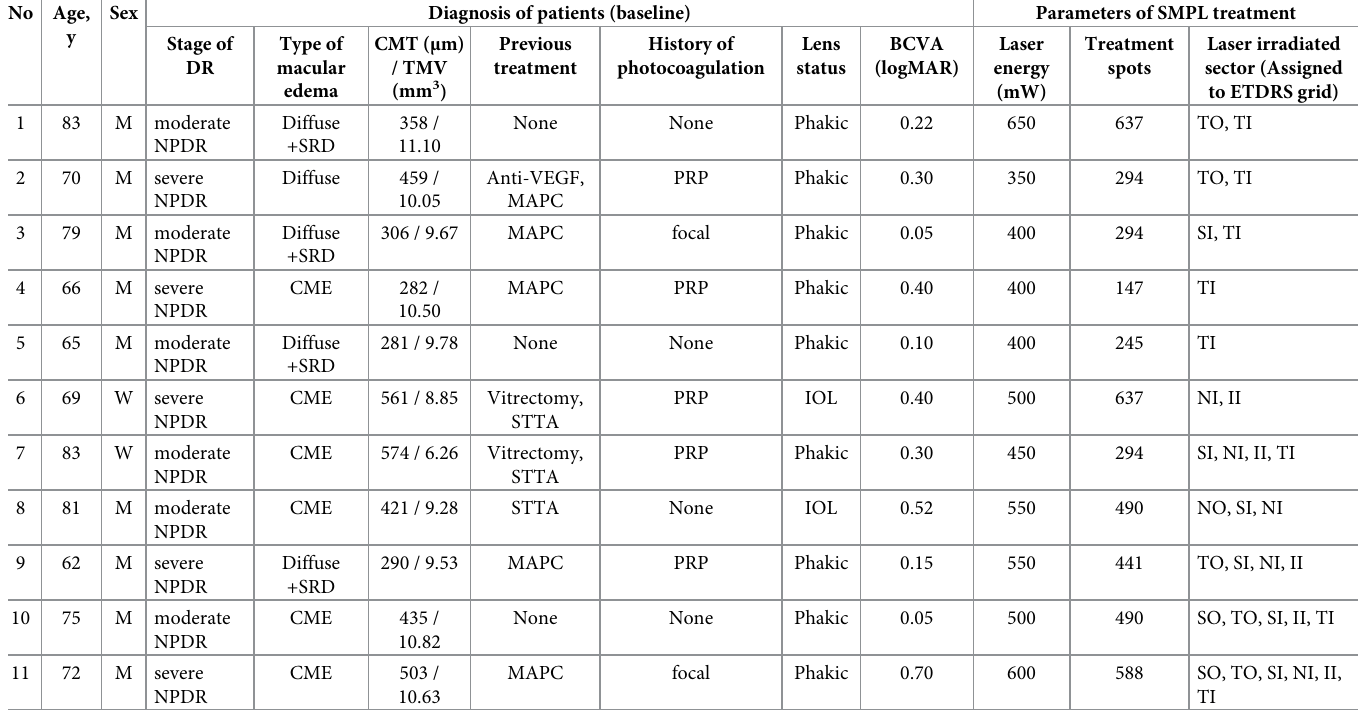
Table 2. Details of DME patients undergoing subthreshold micropulse laser: Diagnosis and laser parameters.